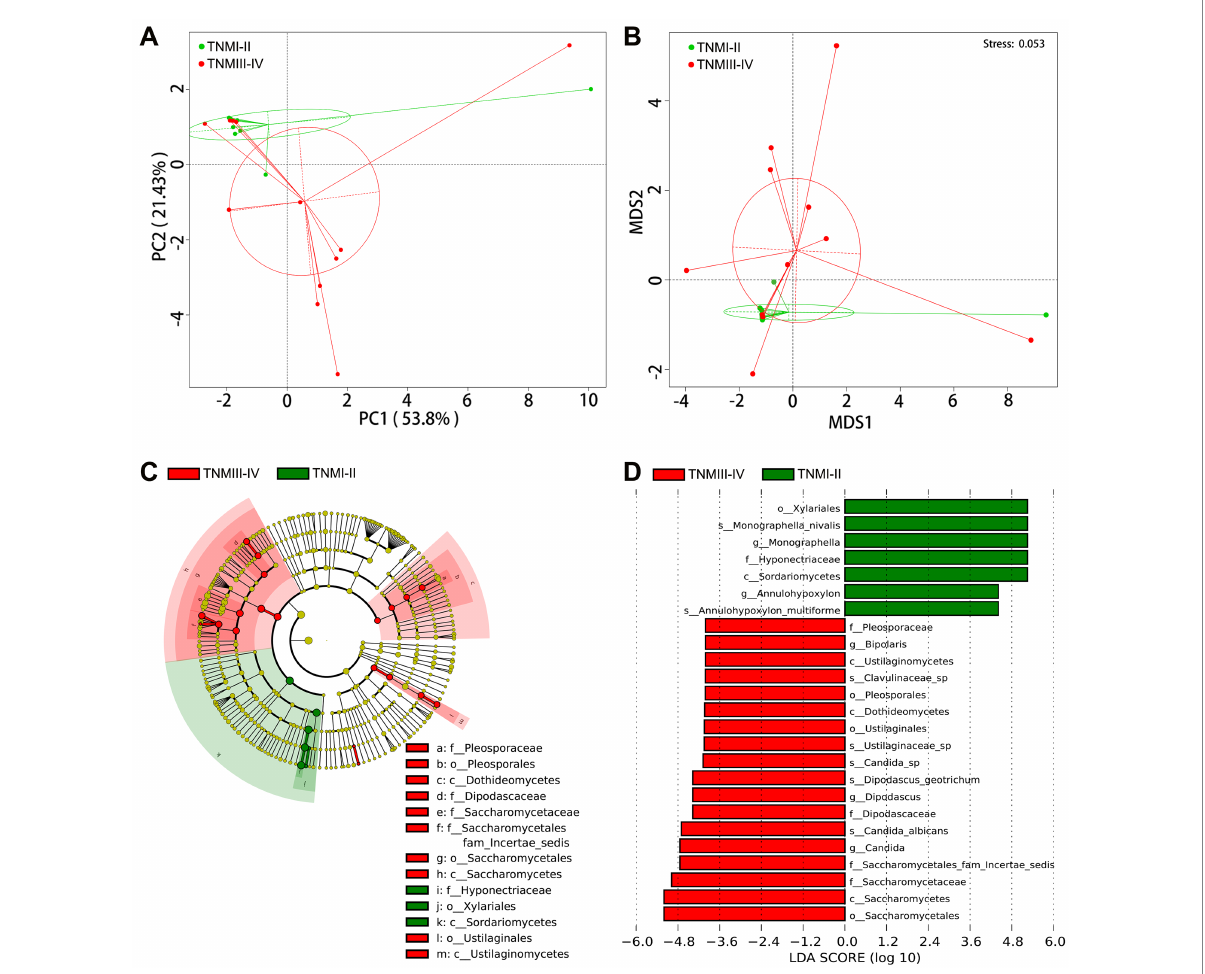
FIGURE 4 Correlation of gut mycobiota with TNM stage in ICC patients. The distributional difference of gut mycobiota profiles was assessed using PCoA (A) and NMDS (B) based on a weighted_unifrac matrix. (C) Taxonomic cladogram from LEfSe showing differences in fecal taxa of ICC patients with stage III-IV and stage I-II. (D) LDA scores were computed for differentially abundant taxa in the gut fungi of ICC patients with stage III-IV and stage I-II. Length indicates the effect size associated with a taxon. p = 0.05 for the Kruskal-Wallis sum-rank test; LDA score > 4; ICC, intrahepatic cholangiocarcinoma; LDA, linear discriminant